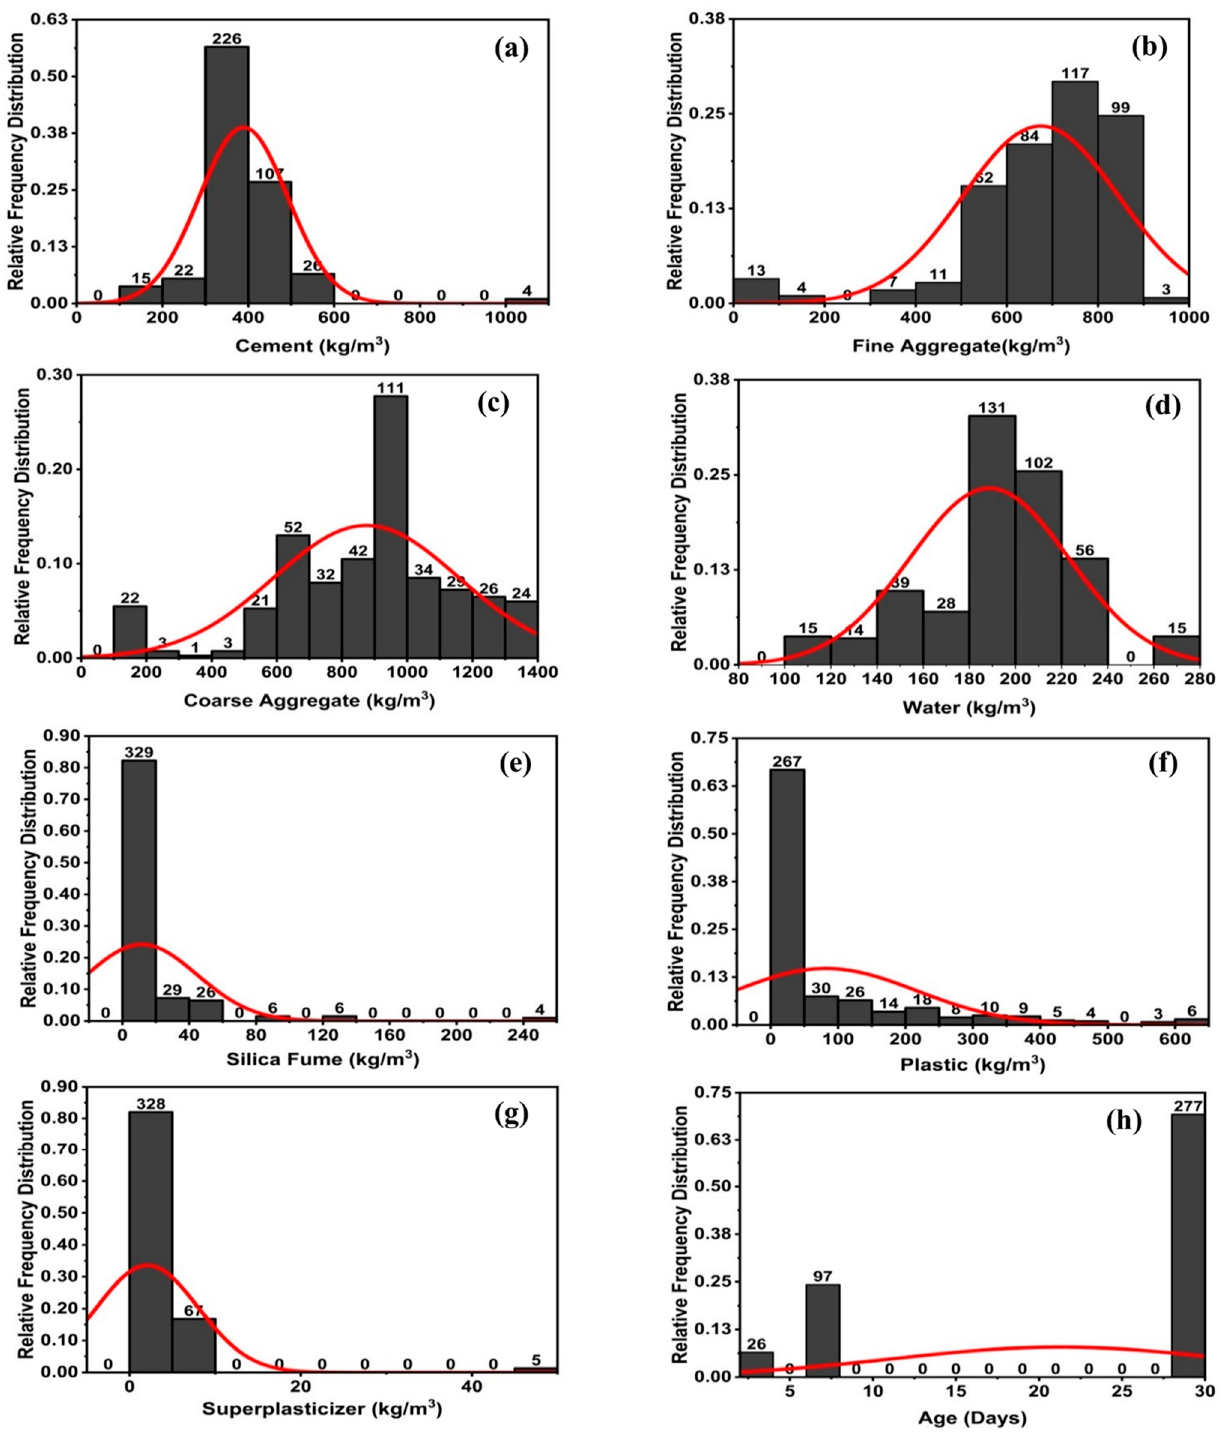
Figure 4. Split tensile strength parameters’ relative frequency distribution; ( a ) cement, ( b ) fine aggregate, ( c ) coarse aggregate, ( d ) water, ( e ) silica fume, ( f ) plastic, ( g ) superplasticizer, and ( h ) age .